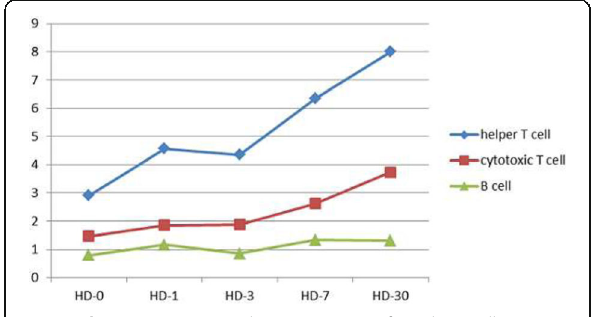
Fig. 2 (abstract 0013). serial measurement of cytokine cells